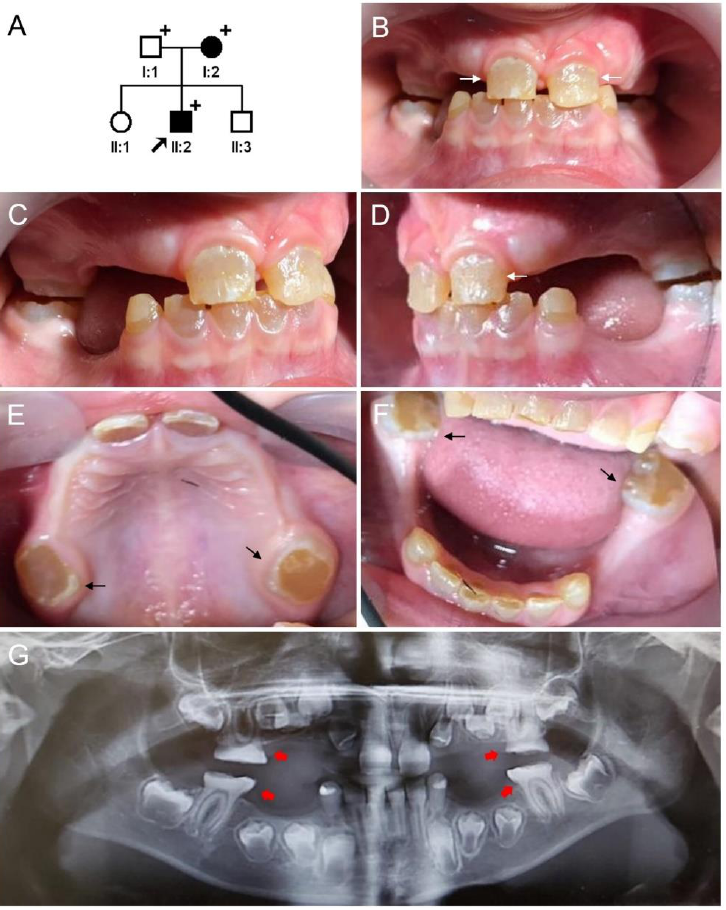
Figure 2. Pedigree, clinical photos, and panoramic radiograph of family 2. ( A ) Pedigree of family 2. Black-filled symbols indicate affected individuals and the proband is indicated by a black arrow. Plus signs above the symbols indicate participating individuals. ( B – F ) Clinical photos of the proband (II:2) at age 9. All of his deciduous teeth except the mandibular canines are missing due to severe attrition. Thin enamel (white arrows) can be seen in the maxillary central incisors and severe attrition can be seen in the first molars (black arrows). ( G ) Panoramic radiograph of the proband at age 9 shows severe attrition in first molars (red arrows). The enamel appears thin and mineralization of the enamel and dentin also appears to be